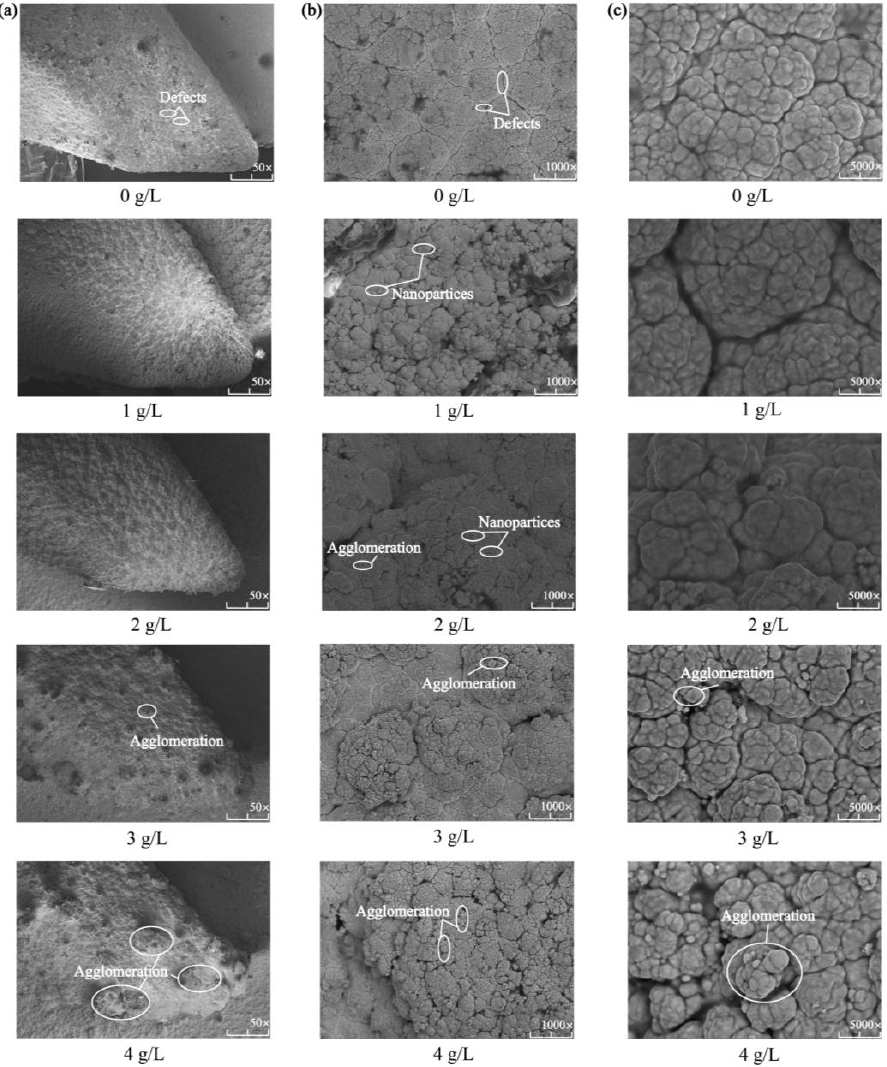
Figure 3. Surface micromorphologies of Ni-Co- β -SiC composite coatings prepared with different β -SiC concentrations: ( a ) 50 magnification, ( b ) 1000 magnification, and ( c ) 5000 magnification.